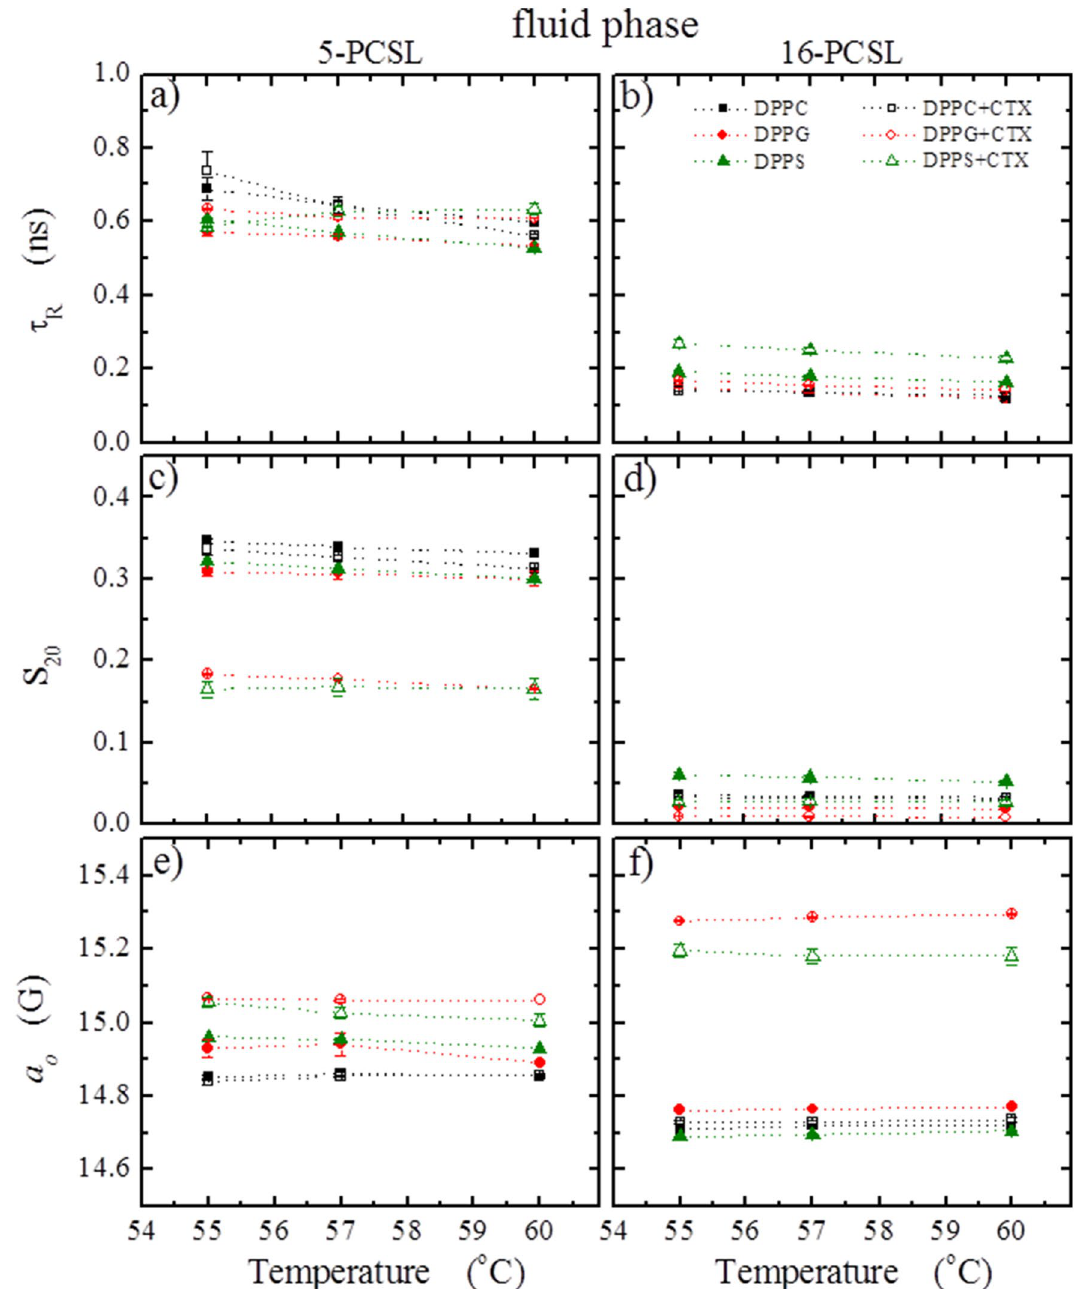
Figure 9. Temperature dependence of the parameters obtained from the best theoretical simulations of the spectra in Fig. 8 ( a and b ) average rotational correlation time τ R , ( c and d ) order parameter S 20 , and ( e and f ) isotropic hyperfine splitting a o . The left and right columns correspond to the parameters obtained from spectra of the spin labels 5- and 16-PCSL, respectively, inserted in pure lipids (solid symbols) and in the mixtures of lipid / protein (open symbols), at the lipid fluid